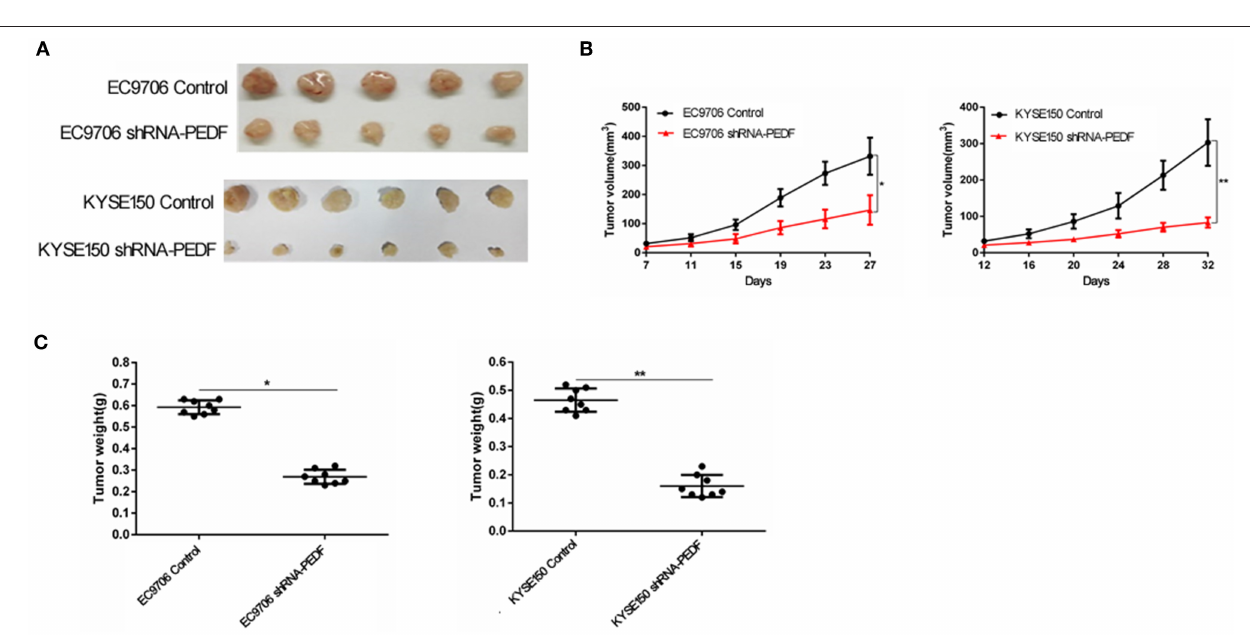
Frontiers in Oncology |